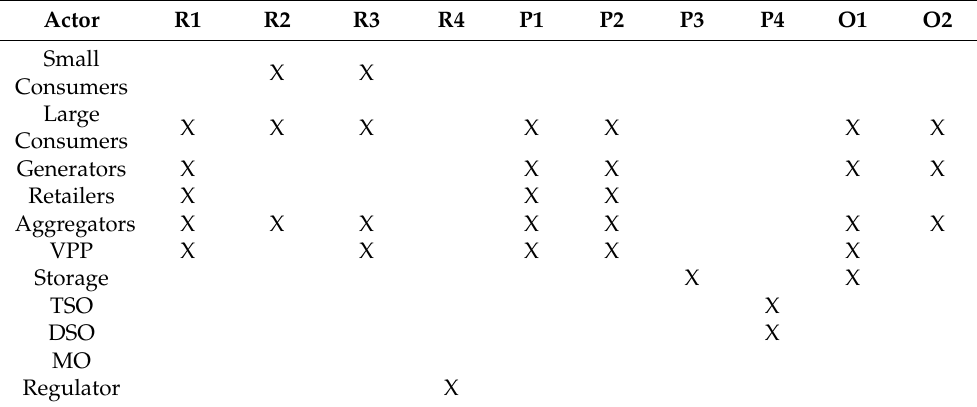
Table 2. Market values from which each agent can